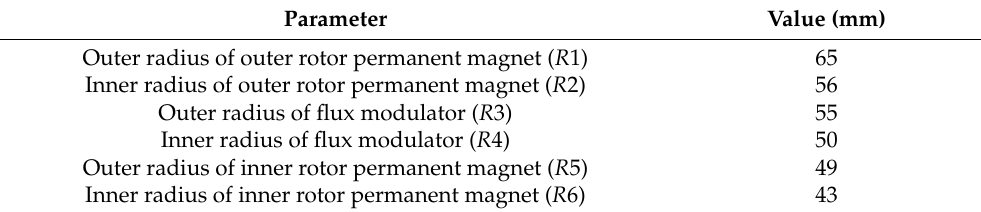
Table 8. Optimum